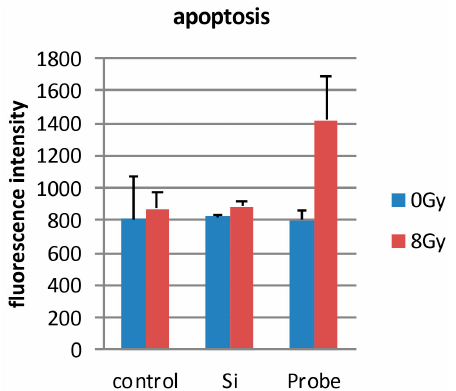
Figure 10. The TUNEL assay shows the highest fluorescence intensity for cells that underwent combination therapy compared to that of other samples. Combination therapy thus induced the greatest extent of apoptotic cell death. Control: SK-BR3 cells; Si: cells in medium containing 1200 ppm PCSNs; Probe: cells in medium containing 1200 ppm PCSN probes. Int. J. Mol. Sci. 2018 , 19 , x FOR PEER REVIEW